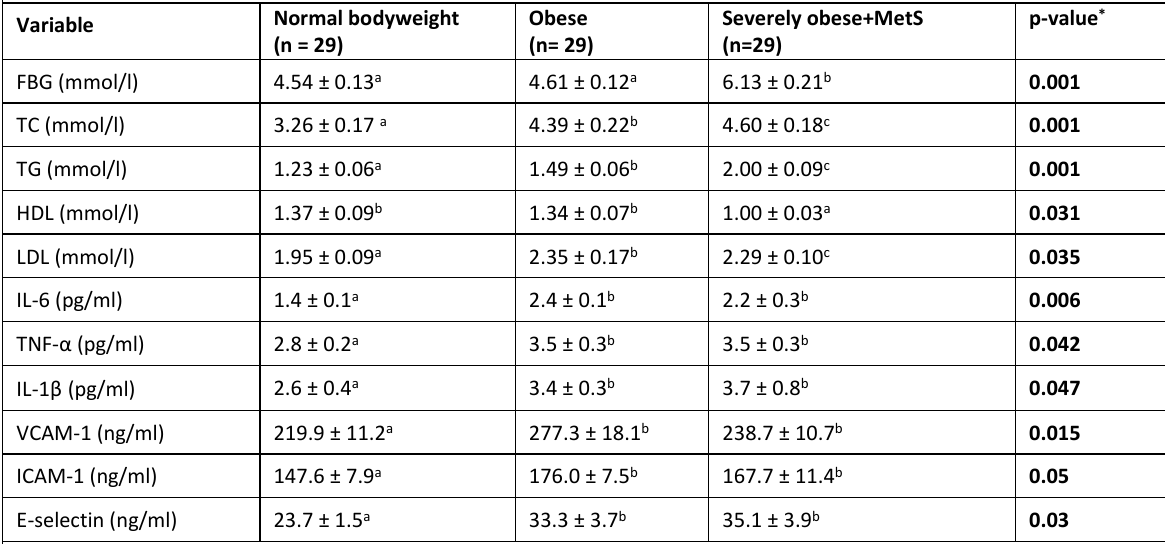
Table 2: Biochemical indicators (fasting) of the study